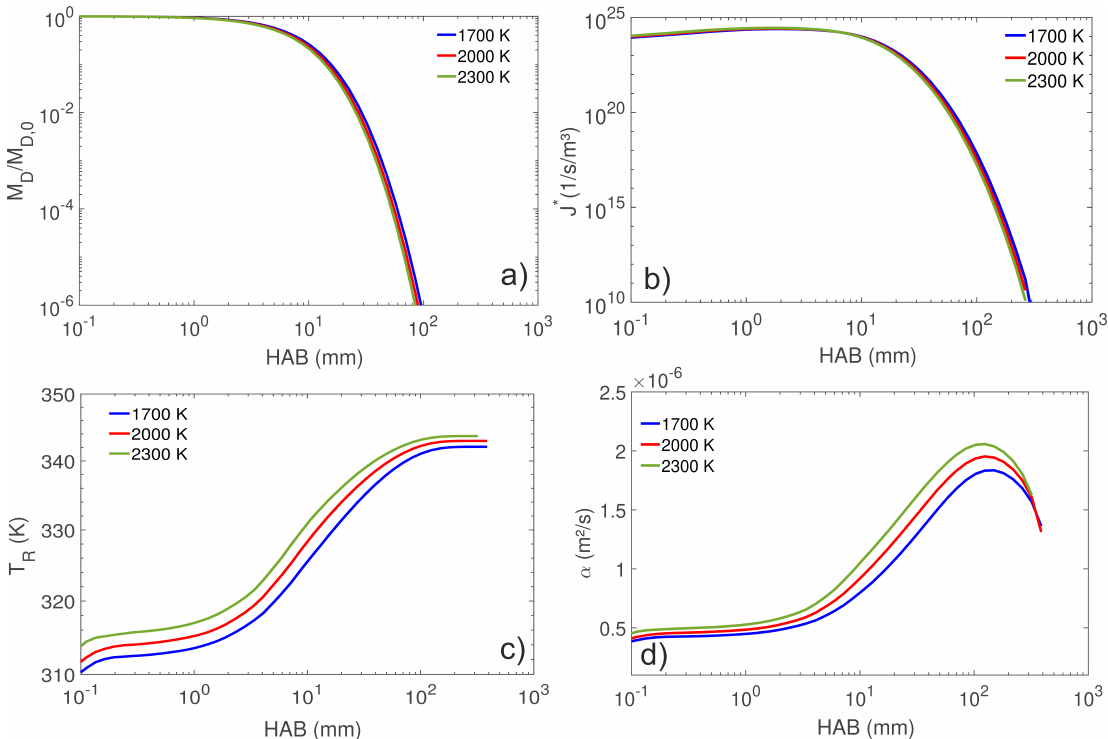
Figure 12. The influence of flame temperature is evaluated for ( a ) the total droplet mass and ( b ) nucleation rate J ∗ over HAB. ( c ) T R of a single droplet and ( d ) α of a single droplet with initially 100µm in diameter. Overall, the flame temperature has only a minor influence on J ∗